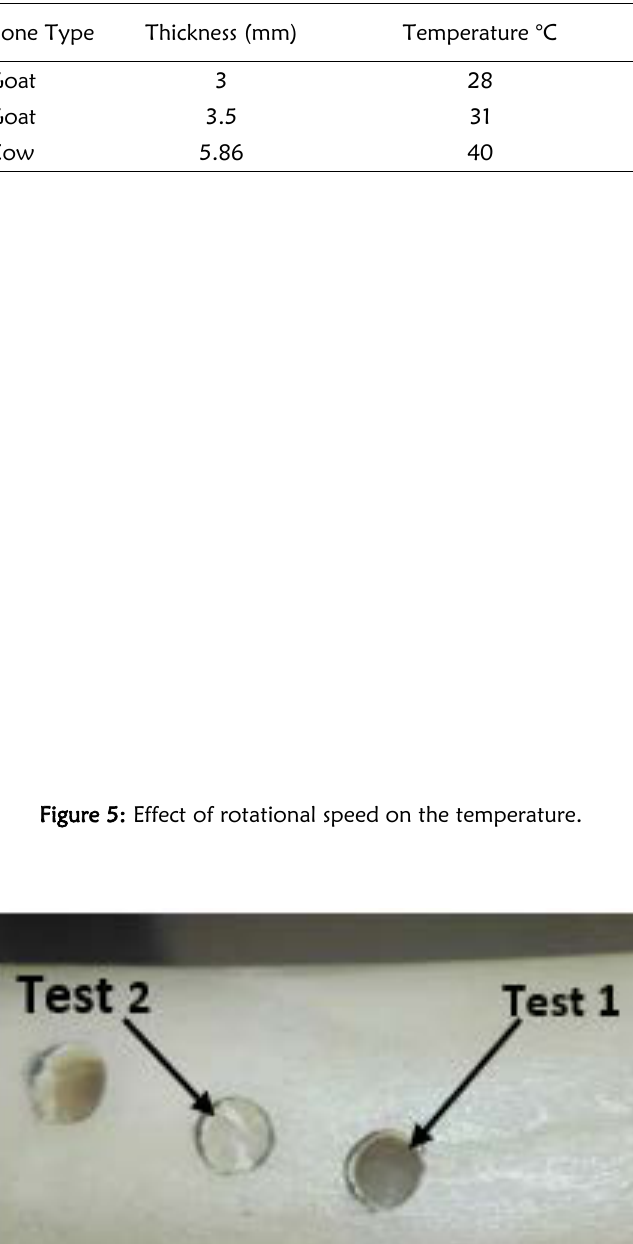
Table 2: Temperature measurements for experiment 2